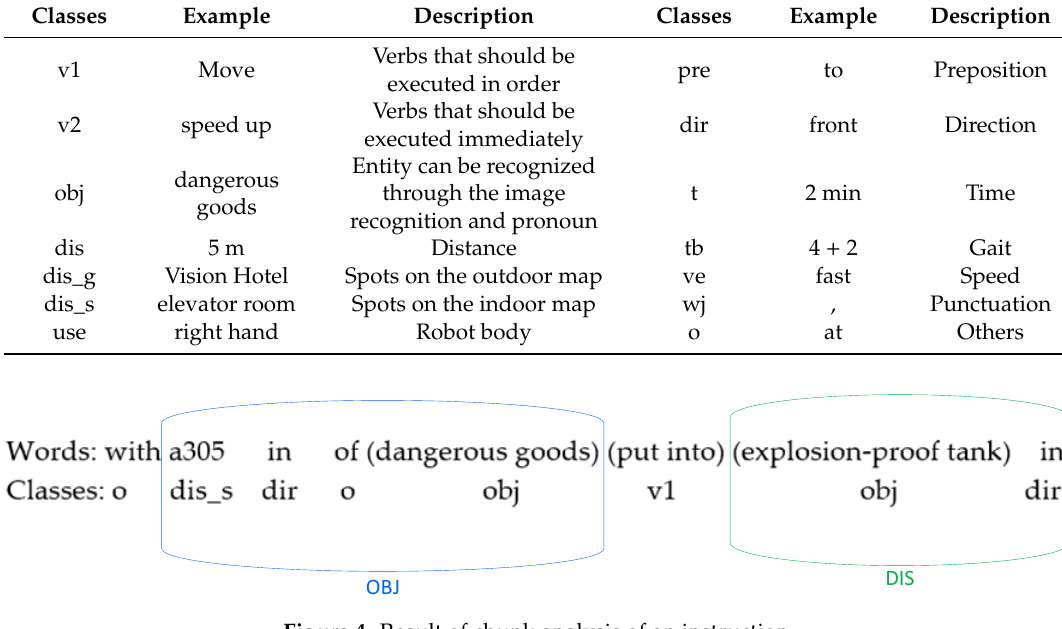
Figure 4. Result of chunk analysis of an instruction.